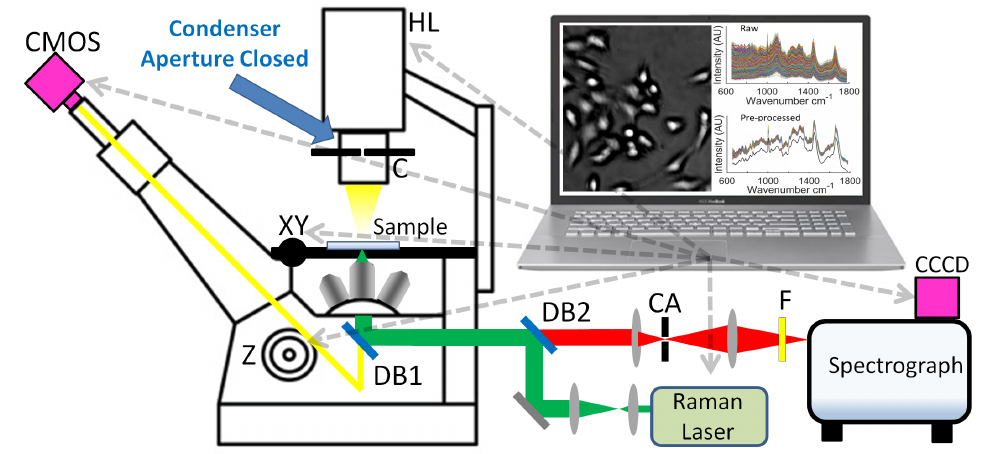
Figure 3. Schematic of opto-electronic system. The computer controls several elements in the system, using an open-source integrated hardware control and image processing system: Micro-Manager. The various components, and symbols, are described in Section